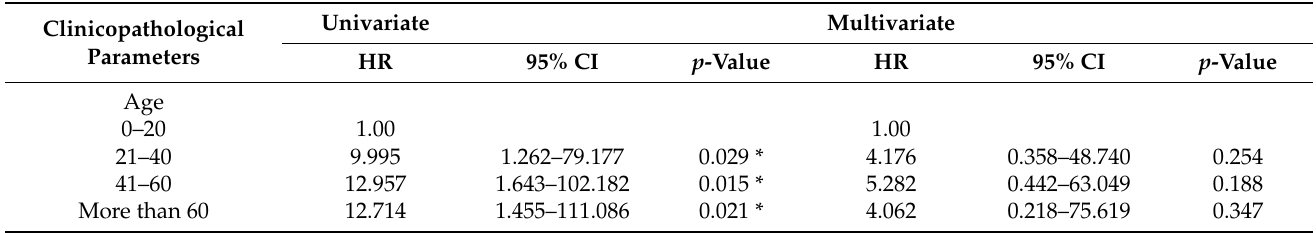
Table 3. Cox regression models for progression-free survival in patients with